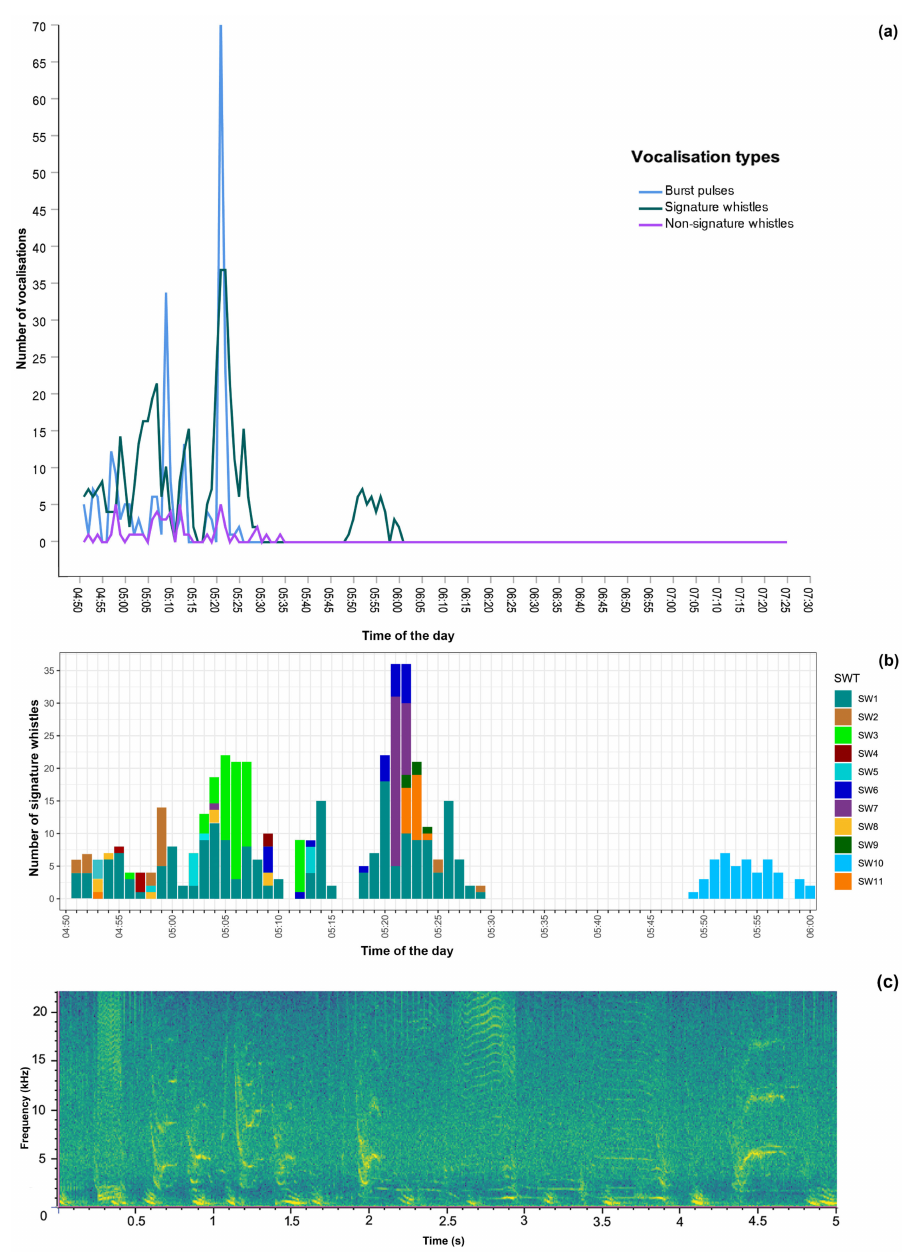
Figure 3. ( a ) The number of vocalisations recorded over time in a 1 min time bin visualization. ( b ) The number of signature whistles emitted per minute divided by signature whistle types (SWT). ( c ) Spectrogram (spectrogram window size: 512, Hann window, overlap 50%) of a vocal sequence extracted from the second peak of vocal activity (05:21